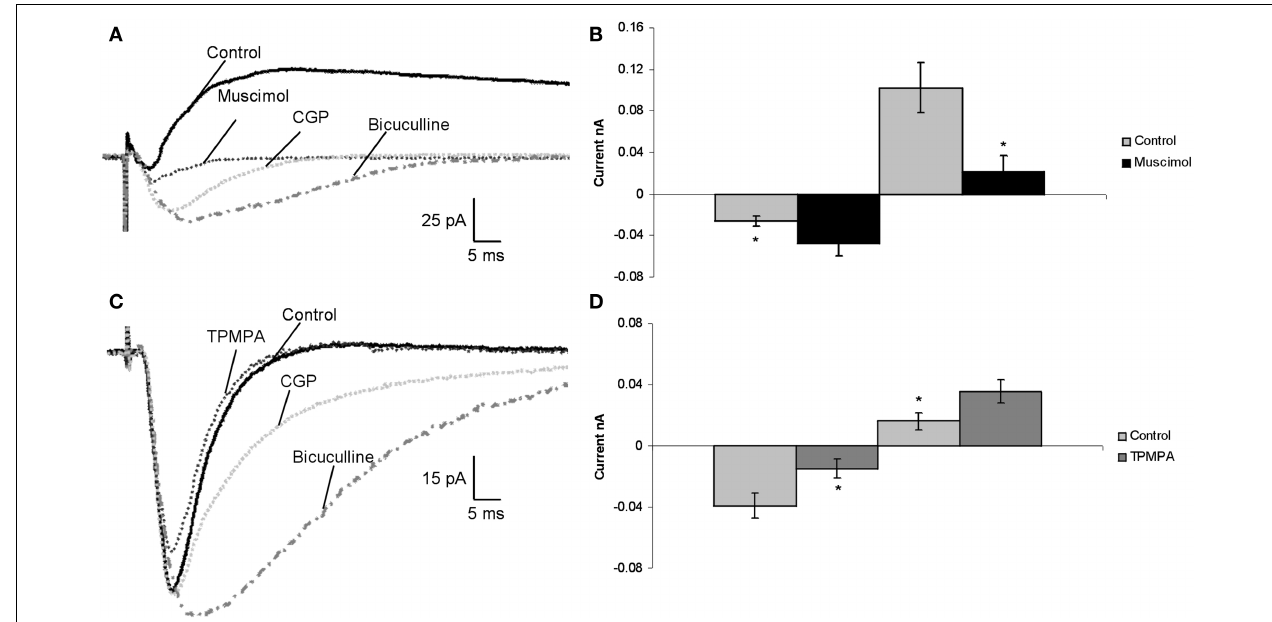
FIGURE 1 | In vitro patch clamp recordings, showed functional GABA Rs in pyramidal cells in the LA compared to Control ( n = 23). (C) Traces of synaptic C the rat LA. (A) Recorded traces of a pyramidal cell in the LA during control, currents of a pyramidal cell in the LA under control conditions, application of application of 1 µM muscimol (GABA R agonist), addition of 50 µM CGP 52432 C (GABA R antagonist), and co-application of 10 µM bicuculline (GABA R B A antagonist). (B) Average effect of 1 µM muscimol on synaptic currents of pyramidal cells in the LA compared to control ( n =